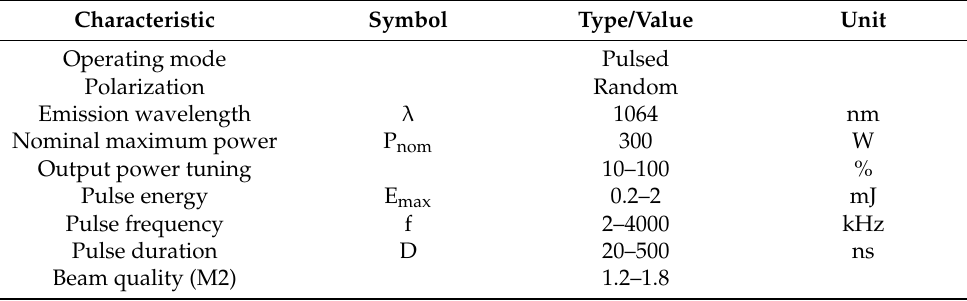
Table 1. Main characteristics and operating range of laser